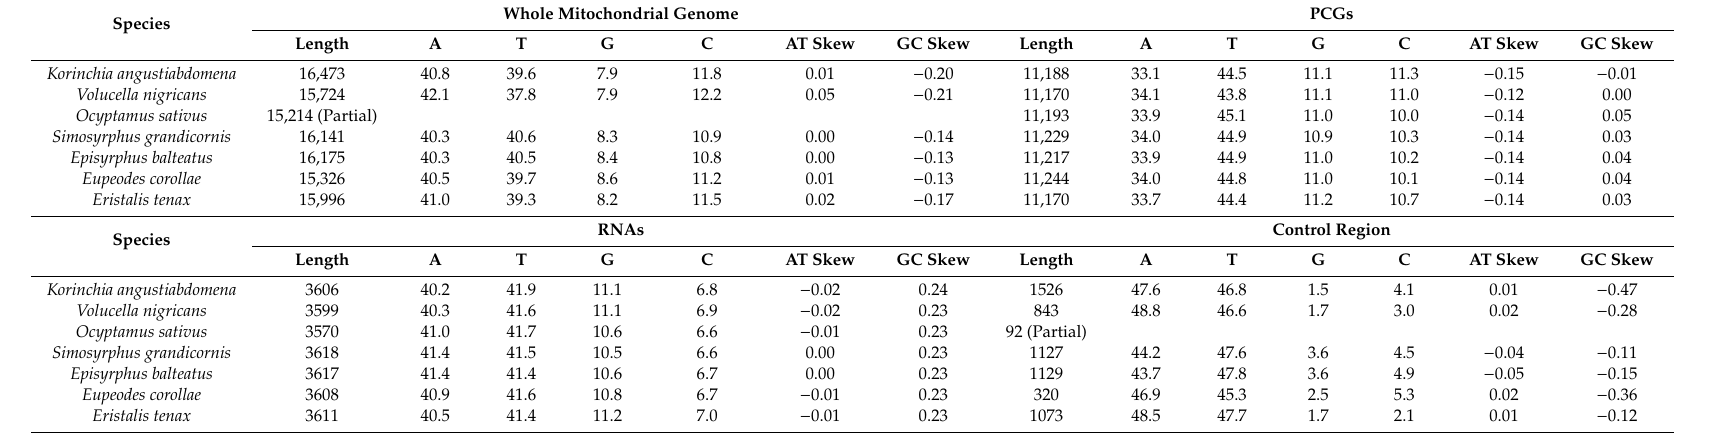
Table 2. AT- and GC-skew in di ff erent regions of seven sequenced Syrphidae